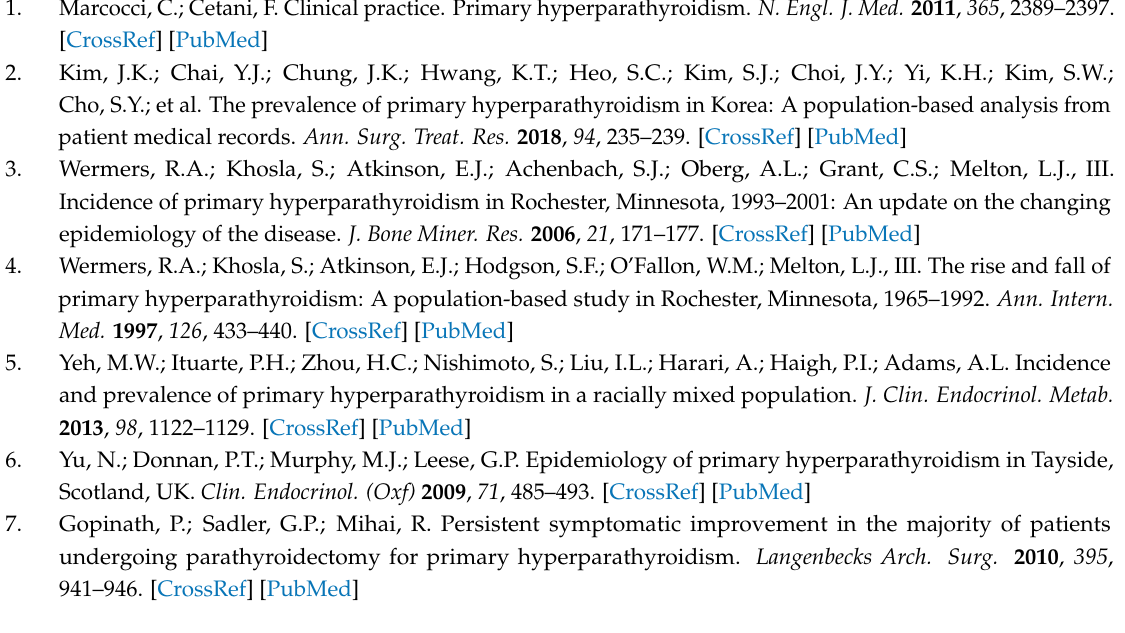
Supplementary Materials: The following are available online at http://www.mdpi.com/2077-0383/8/3/ 297/s1; Table S1: mRNA expression values for genes evaluated in the ten parathyroid adenomas and five normal parathyroid tissue sample, Table S2: List of differentially expressed genes (45 up-regulated and 202 down-regulated), and Table S3: GO terms extracted using down-regulated DEGs, Figure S1: PPI network of genes up-regulated in parathyroid adenoma consisting of 13 nodes and 8 edges (average node degree = 1.231; average local clustering coefficient = 0.00), showing potential functional interactions between up-regulated genes, Figure S2: PPI network constructed using down-regulated genes, which comprised 120 nodes and 230 edges (average node degree = 3.833; average local clustering coefficient = 0.229). PTH is connected with KL and GJA1 proteins (depicted in red squares), showing PTH protein functionally